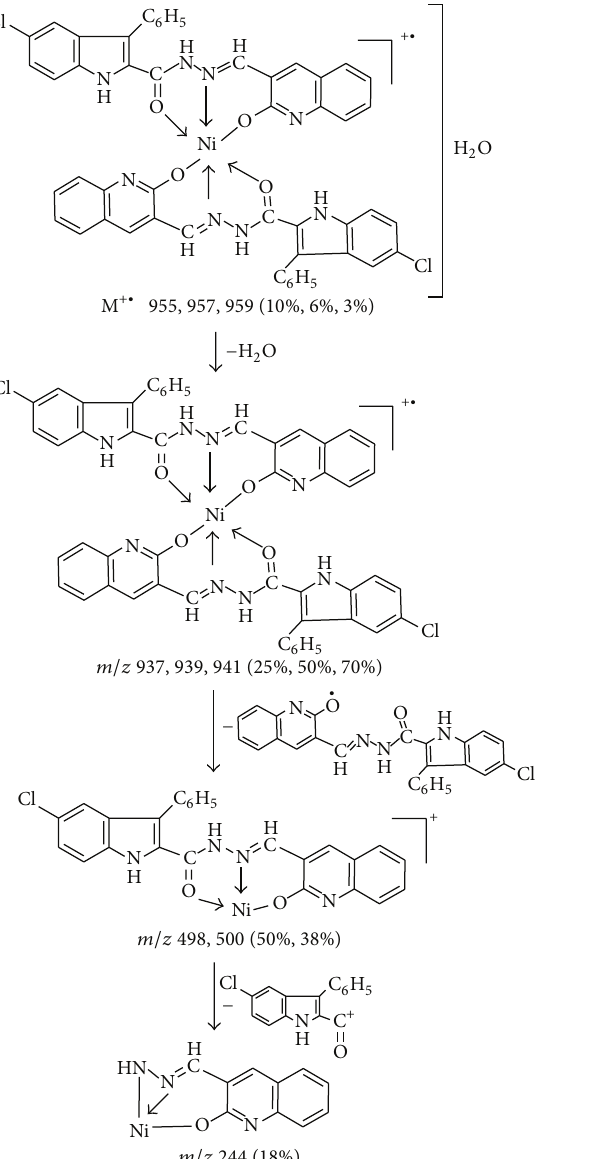
Scheme 2: Mass fragmentation of Ni(II) complex.